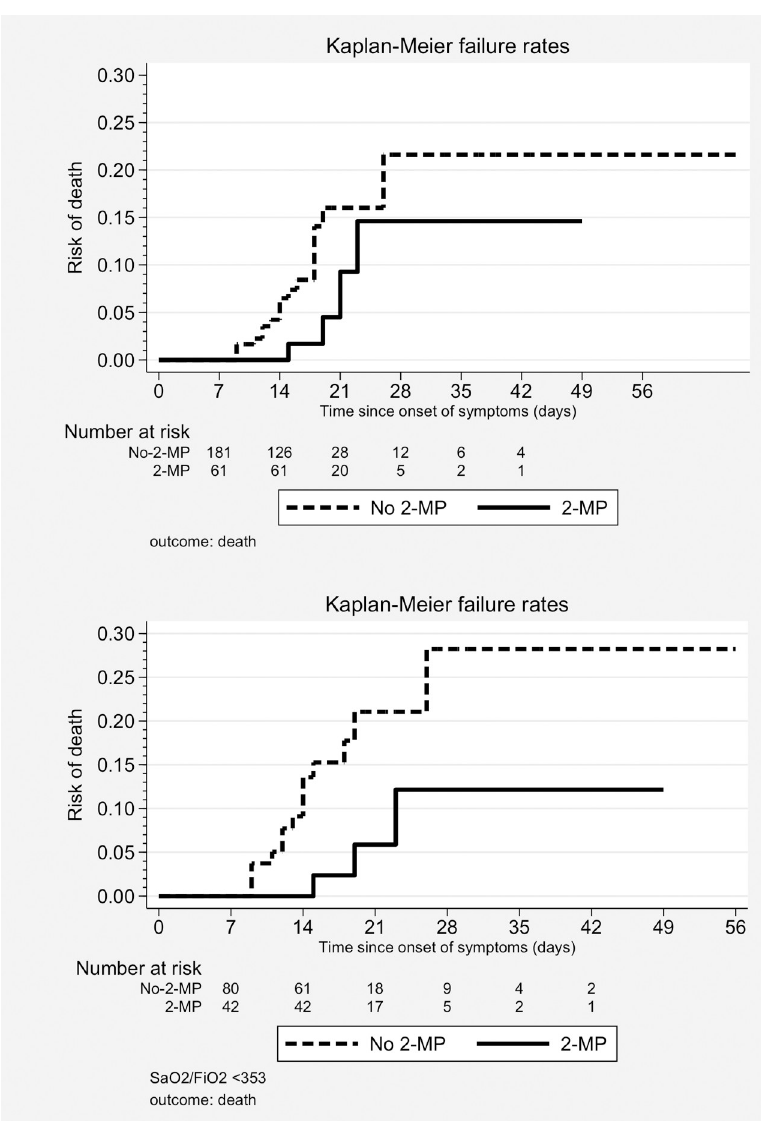
Fig 1. Kaplan-Meier failure curves, second week methyl-prednisolone pulses (2-MP) vs. no 2-MP. Outcome: death. (a) Whole cohort (n = 242). Log-rank test, p = 0.102. (b) Patients with low SpO2/FiO2 (n = 122). Log-rank test, p =